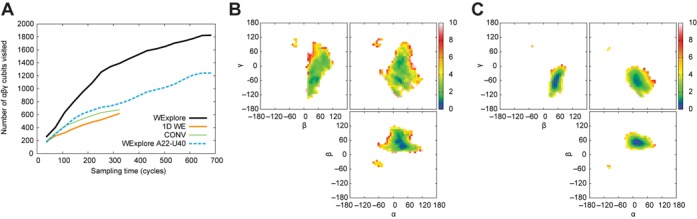
A comparison of sampling in Euler angle space. (A) A comparison of the volume of Euler angle space sampled by three methods: WExplore, 1D WE, and conventional sampling (see Materials and Methods section for details). The dashed blue line shows the sampling of a separate WExplore simulation with a harmonic restraint between bases A22 and U40. An (αh, βh, γh) cubit is defined as a cube in Euler angle space with edge lengths of 10°. Projections of sampling distributions are shown on αh: βh, αh: γh and βh: γh planes for WExplore (B) and conventional sampling (C). For comparison, (B) and (C) both show sampling distributions after 330 cycles (6.6 ns per replica), although the WExplore simulation is continued to 680 cycles (13.6 ns per replica). The color bar in each panel shows the free energy in kT . Color figure is available online.